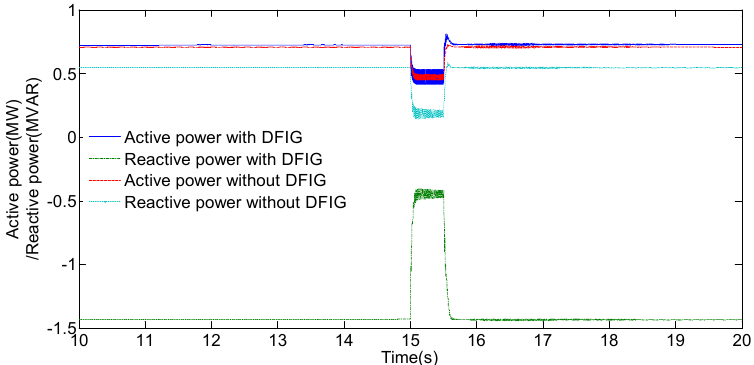
Figure 8. Active and reactive powers at node 3 with and without DFIG connected, where an AG fault is applied at node 3.